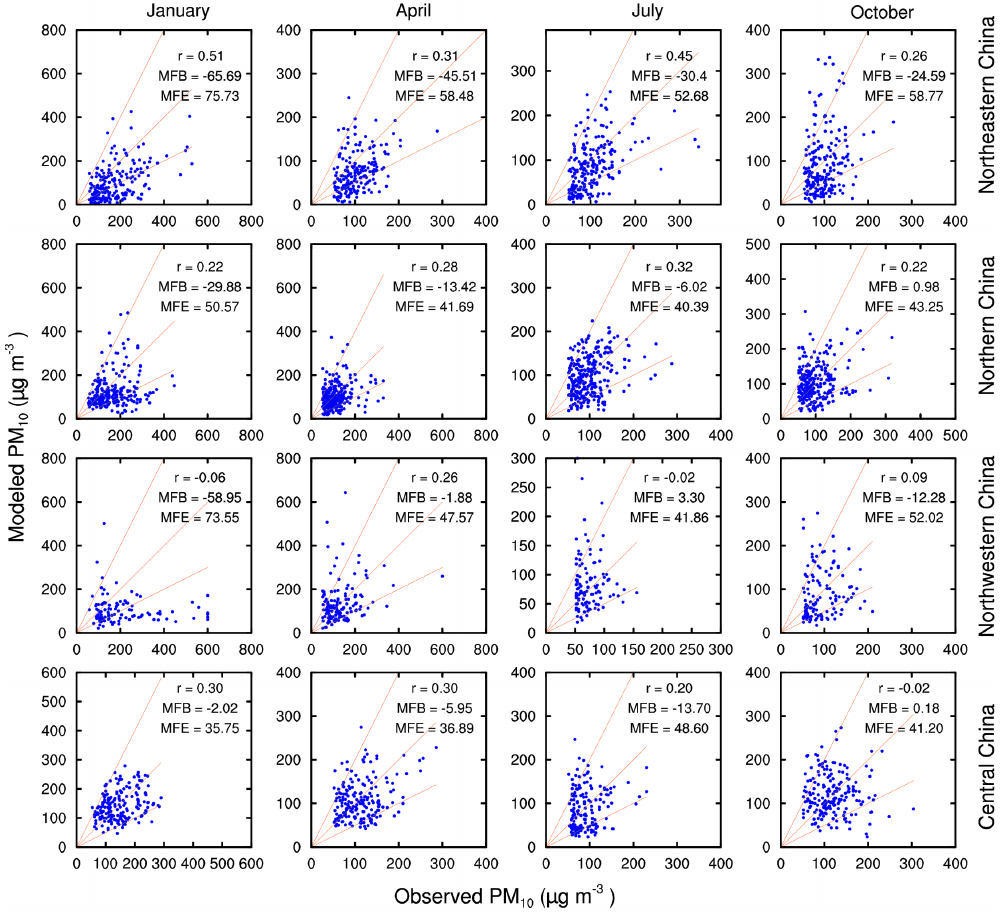
Figure 5. Comparisons of simulated and observed daily mean PM 10 (µgm − 3 ) in northeastern, northern, northwestern, and central China in each month. The model to observation ratios of 2:1, 1:1, and 1:2 are represented by orange lines. Monthly average performance statistics ( r , MFB, and MFE) are